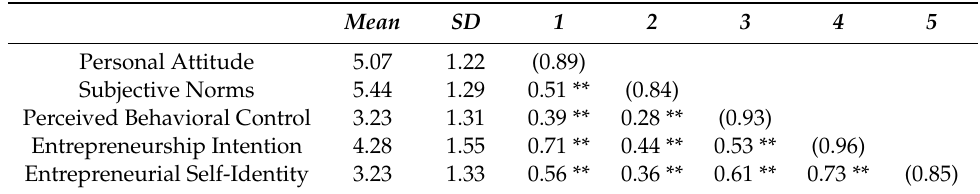
Table 1. Descriptive statistics. Cronbach’s alpha and correlation of the questionnaire factors (N = 153).